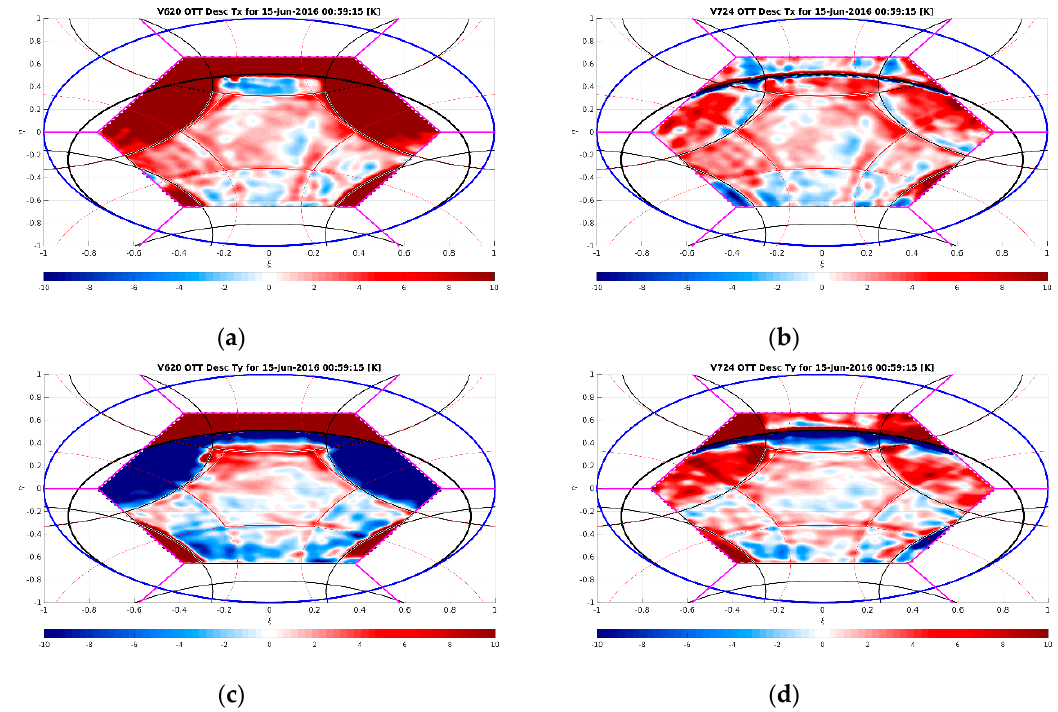
Figure 16. Spatial biases for descending orbits in ( a ) v620 X polarization, ( b ) v724 X polarization, ( c ) v620 Y polarization and ( d ) v724 Y polarization.